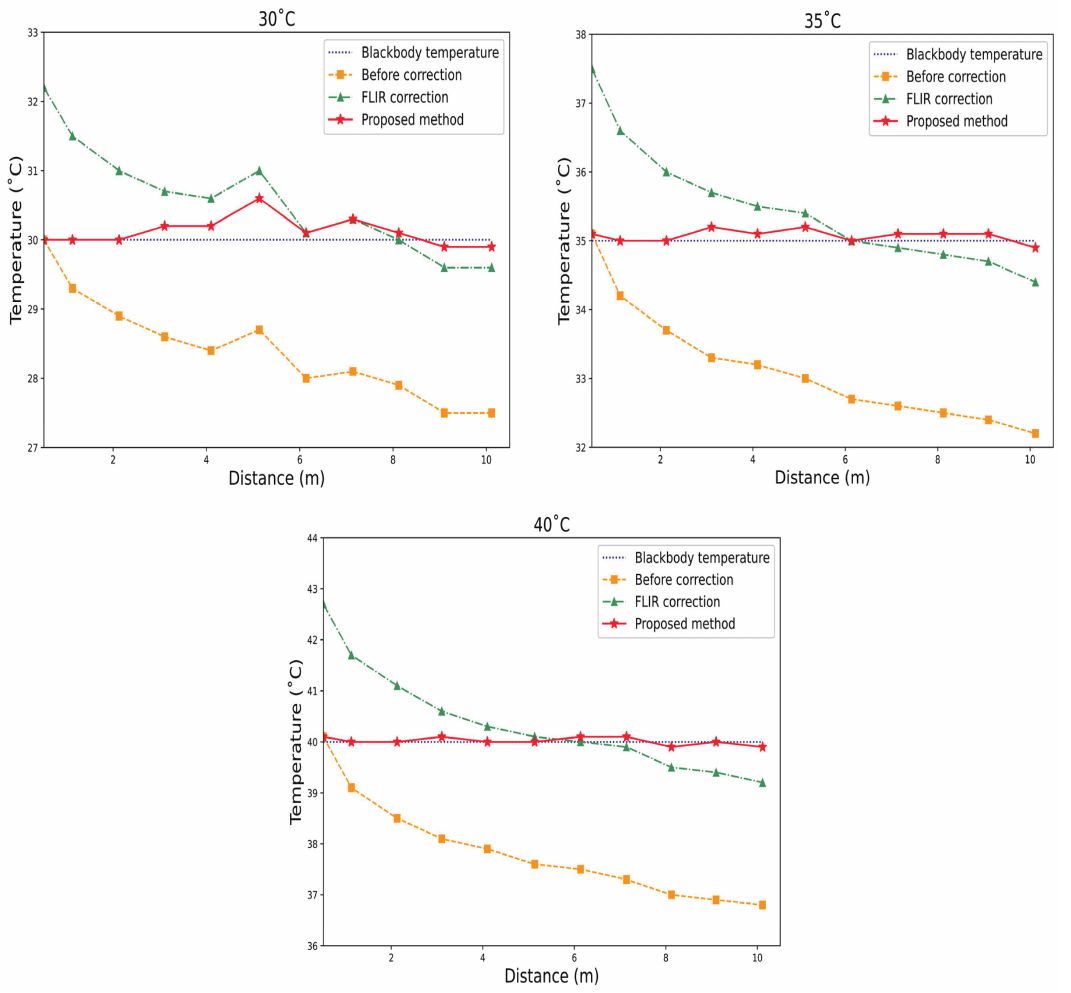
Figure 15. Temperature estimation result according to distance by